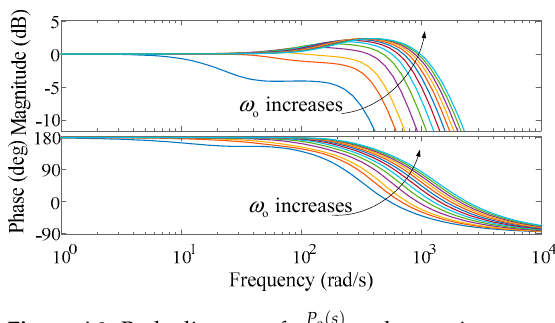
( s ) when ω c increases. P noise ( s )